Question: What form of chart is displayed?
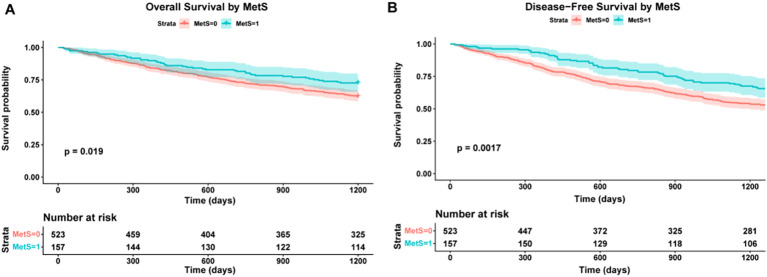
Answer: survival